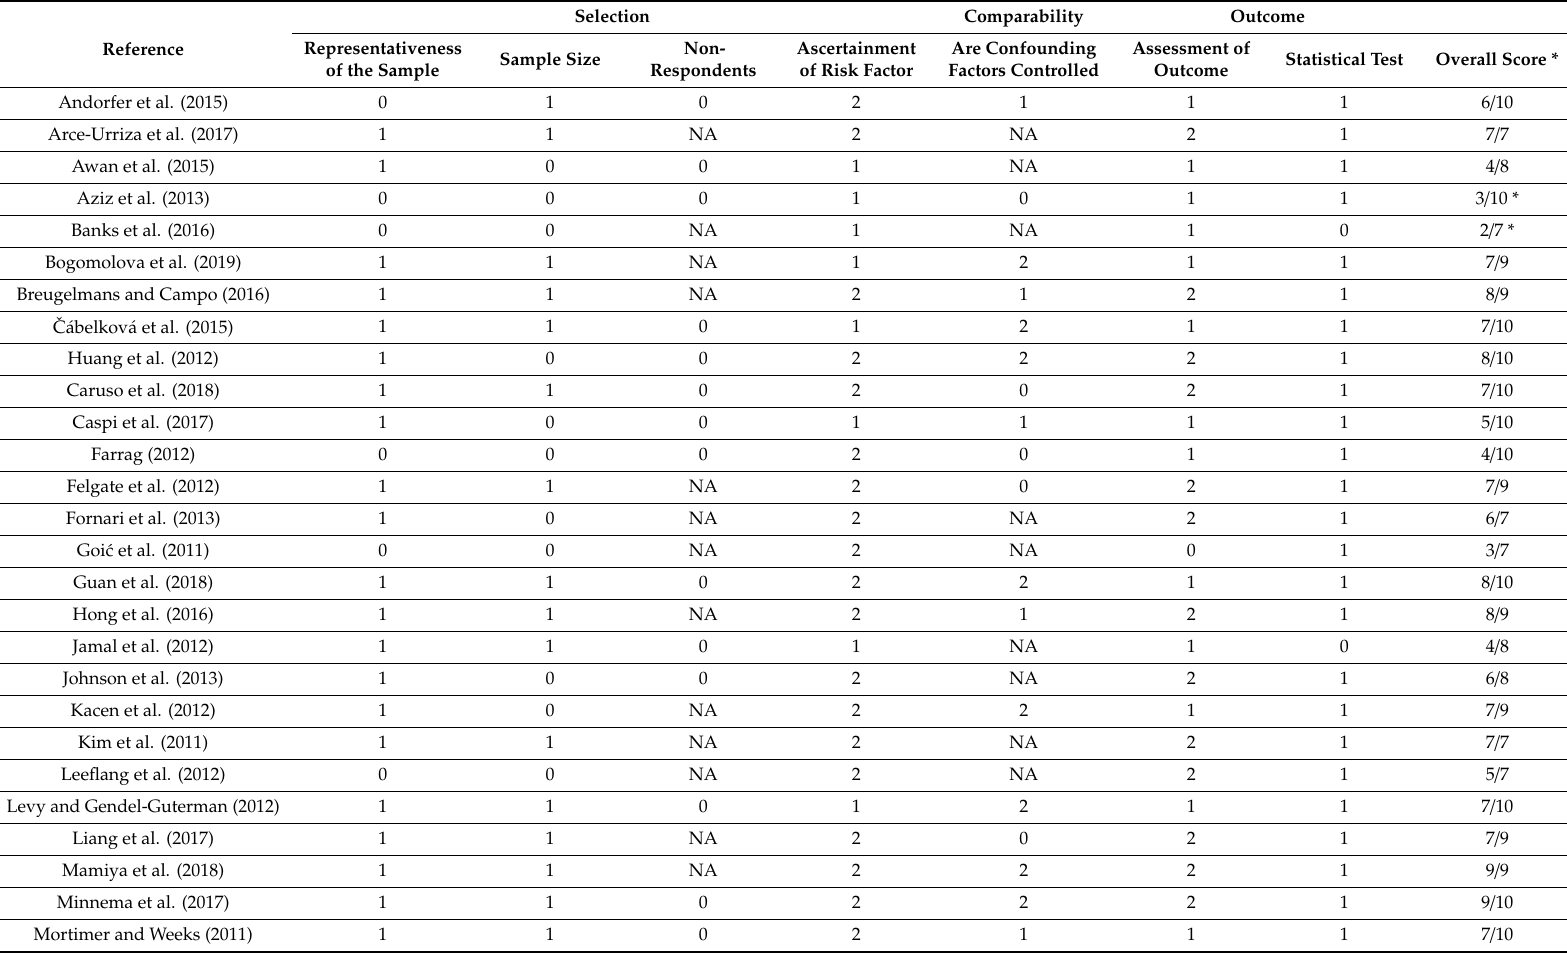
Table A2. Quality assessment of the included studies using the Newcastle–Ottawa quality scale ( n =